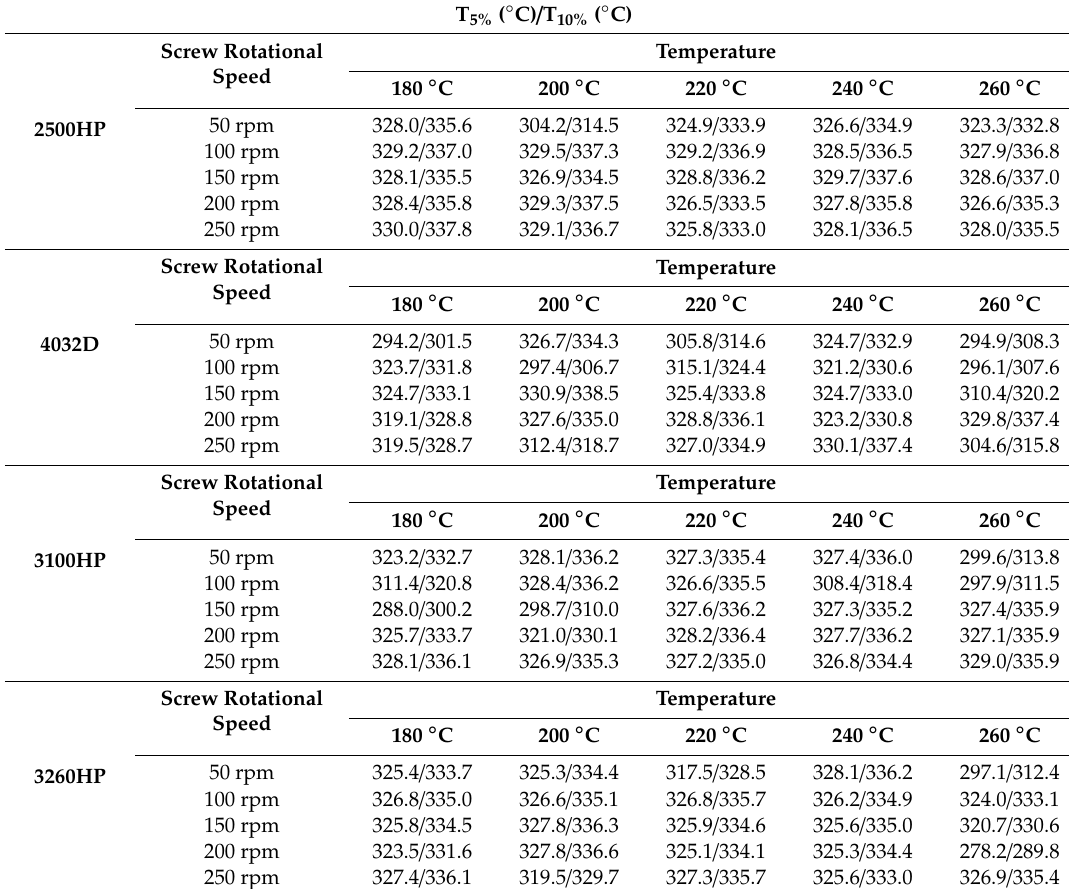
Table 7. The temperature of 5% and 10% mass loss obtained for PLAs processed with various processing